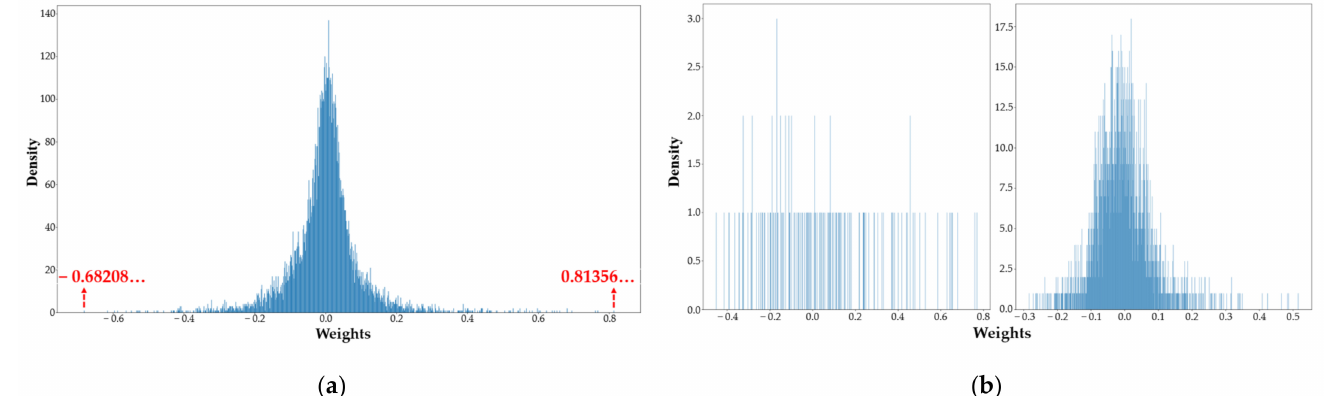
Figure 1. Weight distributions of CNNs. ( a ) Weight distribution of the first convolutional layer in GoogLeNet on Mini-ImageNet. ( b ) Weight distributions of the first and second convolutional layers in LeNet-5 on